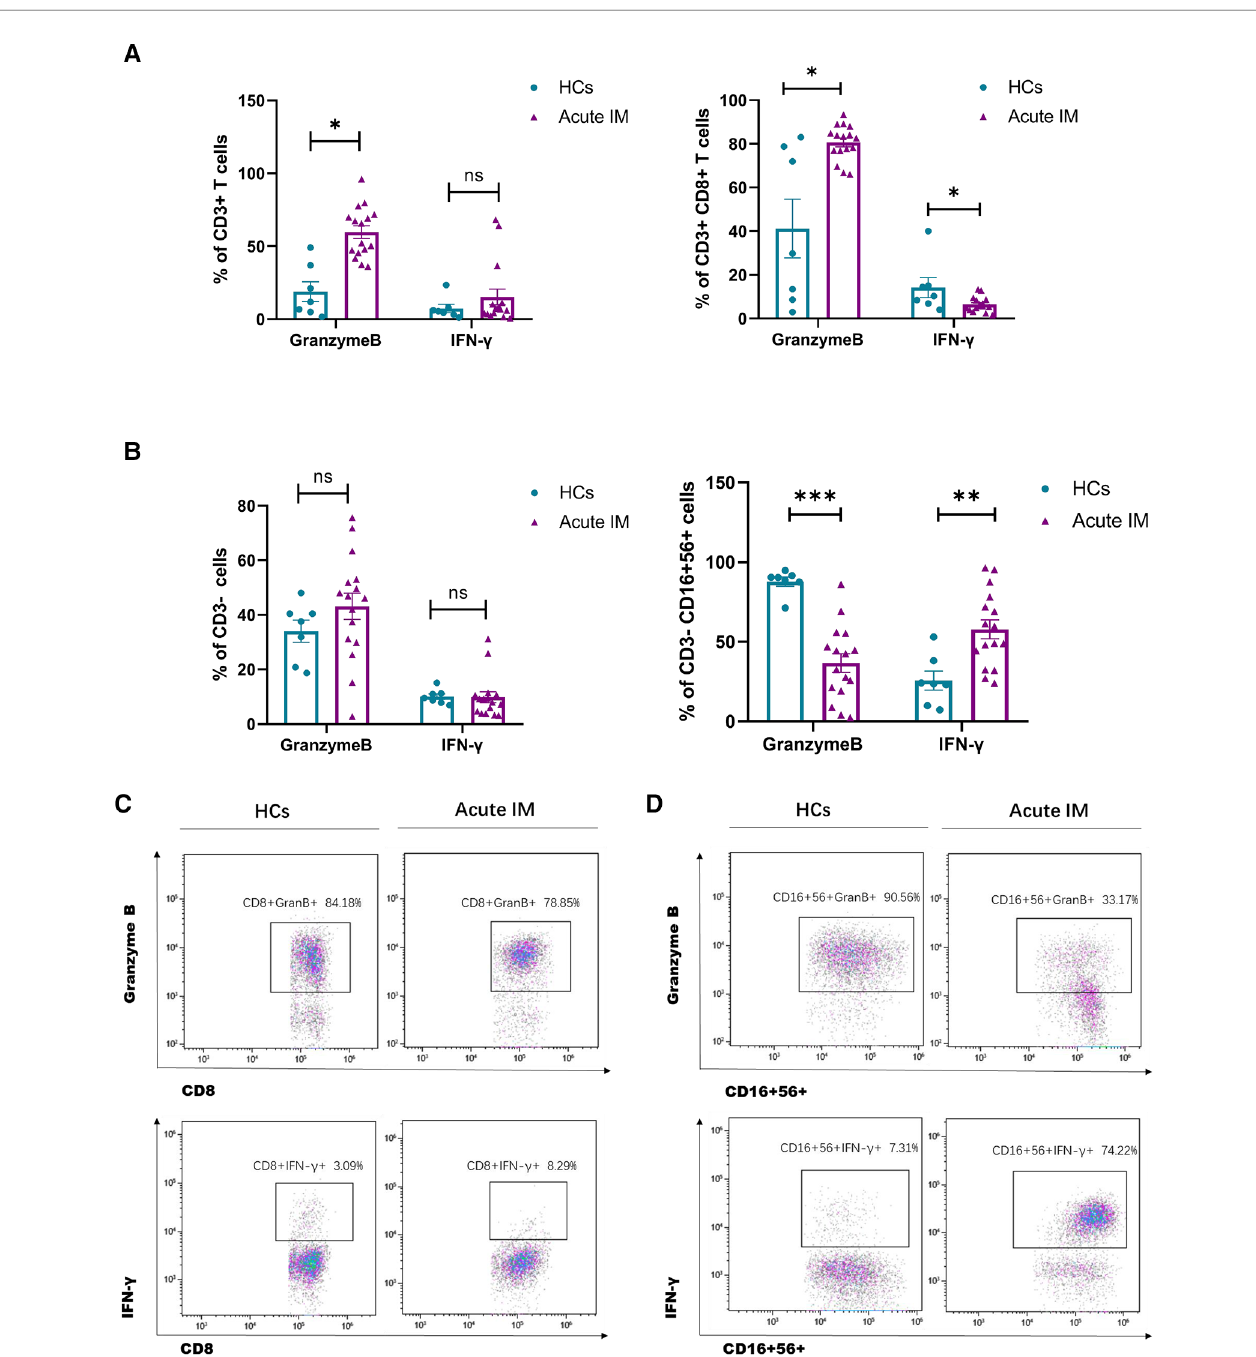
FIGURE 3 Analysis of the effector function of CD8 + T cells and NK cells. PBMCs isolated from IM patients and HCs were stimulated by PMA/ionomycin. Intracellular IFN- γ and granzyme B staining were performed. The frequency of granzyme B and IFN- γ producing CD3 + T 、 CD3 + CD8 + T cells ( A ) and CD3 − 、 CD3 − CD16 + 56 + cells (C ) were measured by fl ow cytometry. Representative dot plots showing the production of granzyme B and IFN- γ in CD8 + T cells ( B ) and NK cells ( D ). Data are expressed as the means±SD. * P <0.05, ** P <0.01, *** P